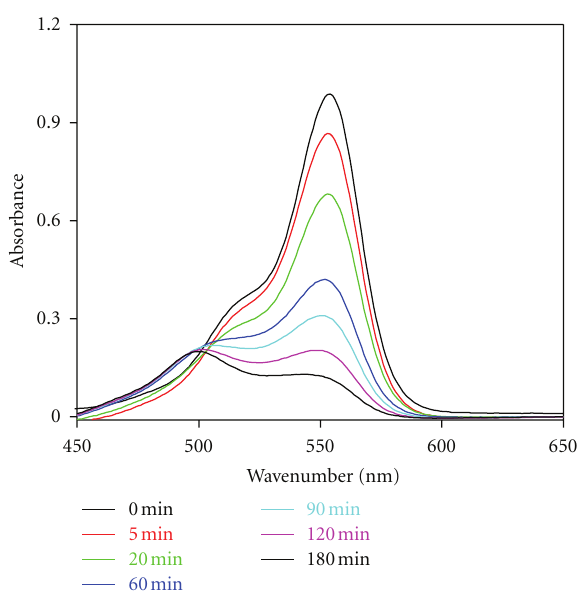
Figure 8: The dependence of absorbance ( A ) of RhB aqueous solution on the visible-light irradiation